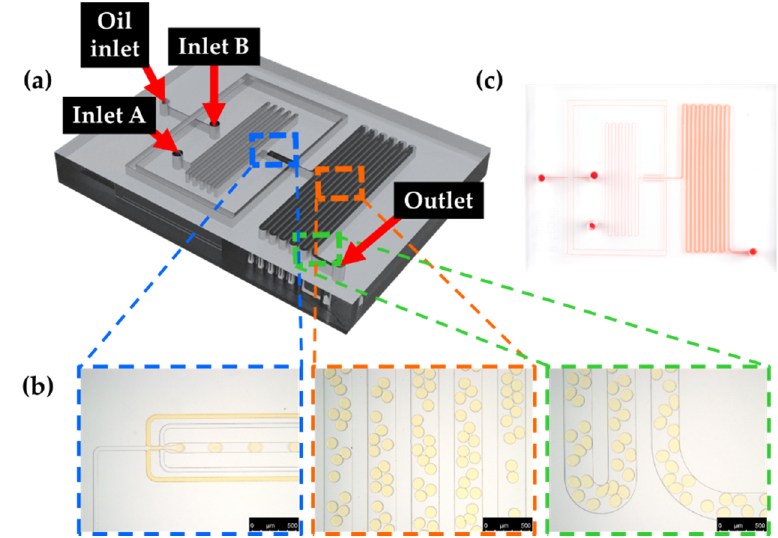
Figure 5. Droplet generation using the microfluidic device. ( a ) Schematic diagram of the microfluidic device for droplet generation. ( b ) Microscopic images of flow-focusing structure (blue box) for droplet generation, incubation channels (orange box) and outlet (green–box) (scale bar = 500 μ m). ( c ) A photographic image of the fabricated PDMS microfluidic device. The microfluidic channel was visualized with red food coloring.